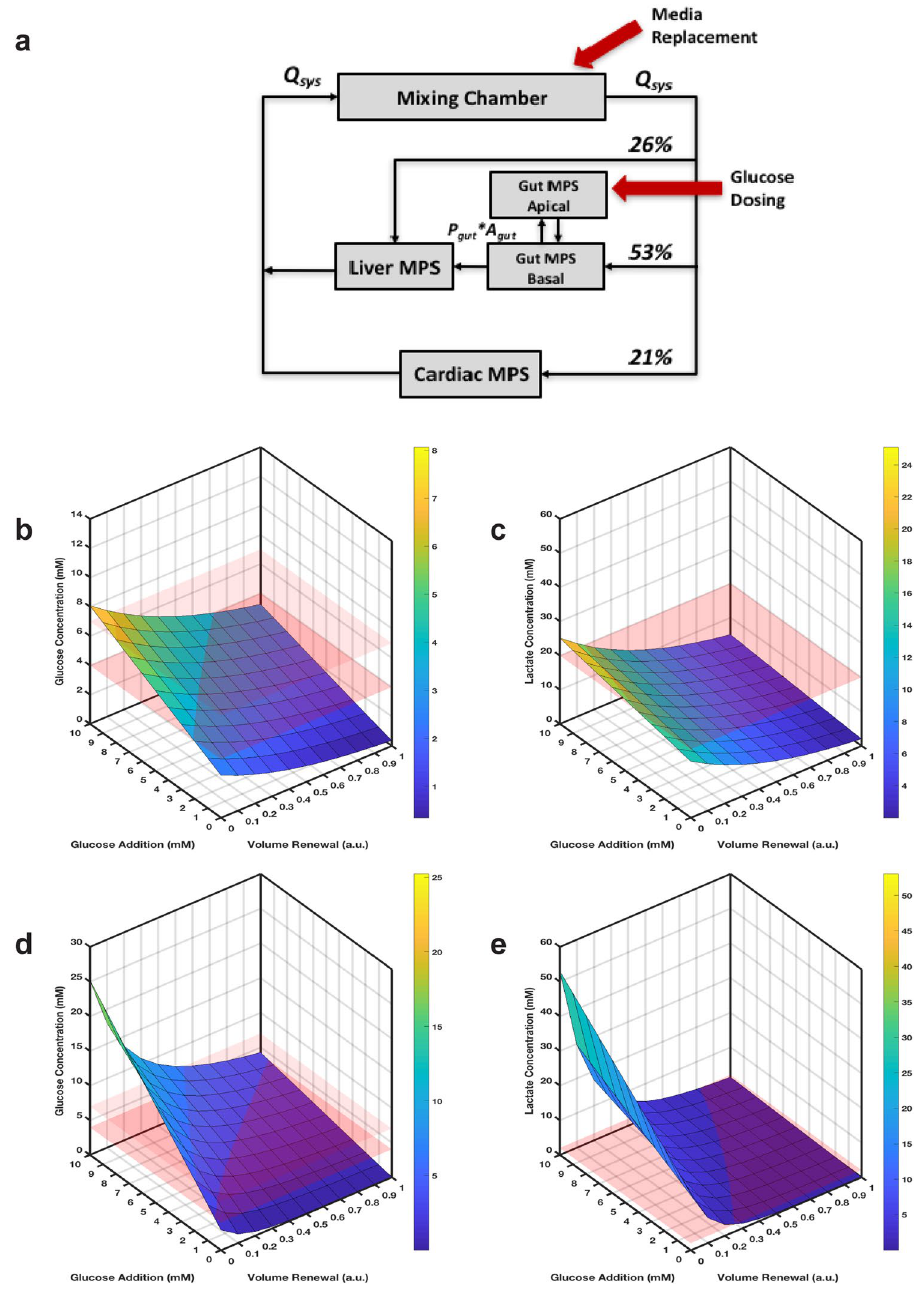
Figure 7. Simulation of quasi-steady state operational media change protocols for an integrated 3-MPS platform. Operational strategies were investigated for an integrated 3-MPS platform ( a ) consisting of gut, liver and cardiac MPSs as well as a mixing chamber to identify protocols that could maintain glucose and lactate concentration within desired ranges. ( b ) Desired glucose concentration: 4–7 mM (between red planes); ( c ) desired lactate concentration: < 20 mM (below red plane). Media change protocols simulated were replacement of media volume every 24 h from the basal site of the gut (0-100%, 10% steps) and supplementation of glucose every 24 h to the apical site of the gut (0–10 mM, 1 mM steps) for 10 days, with the final glucose ( d ) and lactate ( e ) concentrations represented by the simulated surfaces. ( d ) Desired glucose: 4–7 mM (between red planes); ( e ) desired lactate: below 2 mM (physiological levels; below red plane). The range of media change protocols were simulated as in ( b ) and ( c ) except the replacement/replenishment interval was 6 h. The simulated surfaces are the final glucose (left) and lactate (right) concentrations after 10 days. The color of the surfaces in ( b ), ( c ), ( d ), and ( e ) corresponds to the colorbar on the right-hand side and to values on the z-axis, i.e. represents glucose (left, b and d) and lactate (right, c and e)